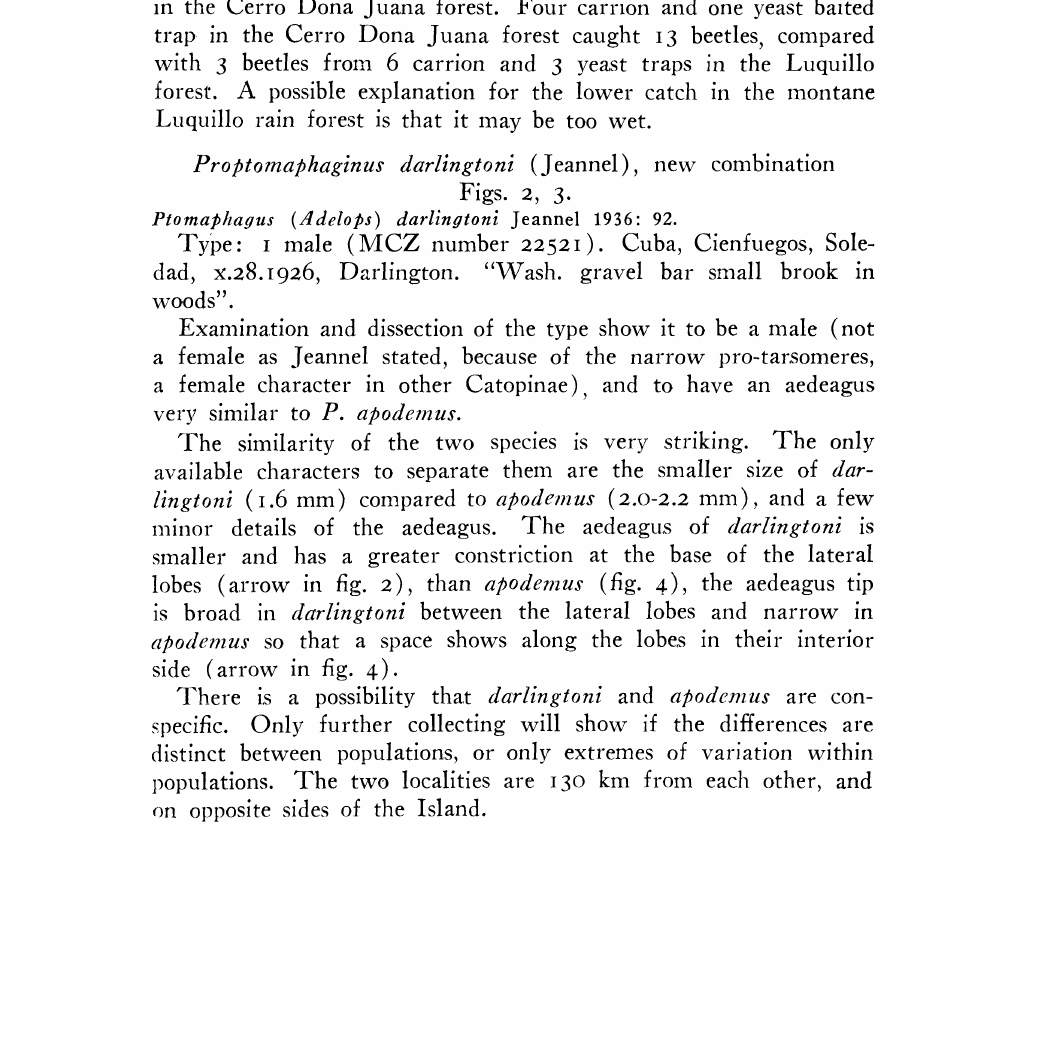
Figs. 2, 3. Plomaphagus (/ldelops) darlintTtoni Jeannel 1936: